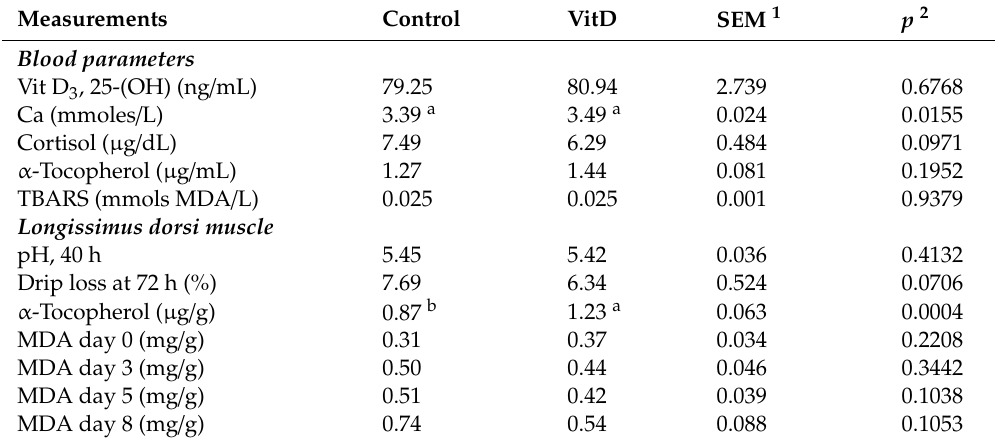
Table 1. Blood parameters and muscle quality measurements from pigs supplemented with vitamin D 3 or without supplementation prior to slaughter (experiment